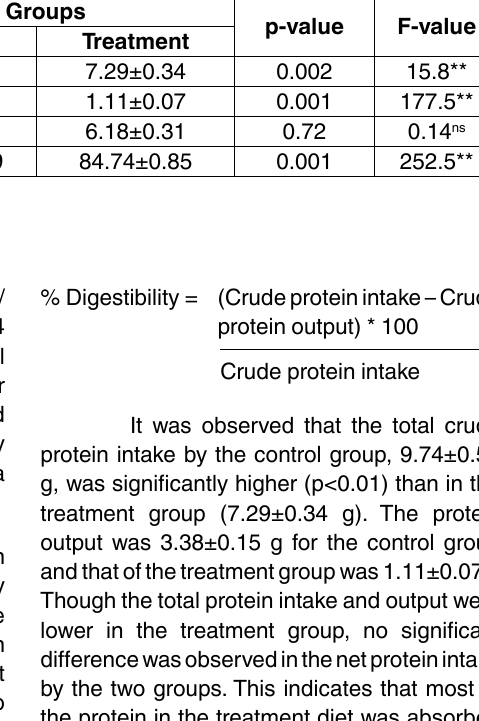
table 6. Summarized data on crude protein intake and digestibility of experimental diets Parameters